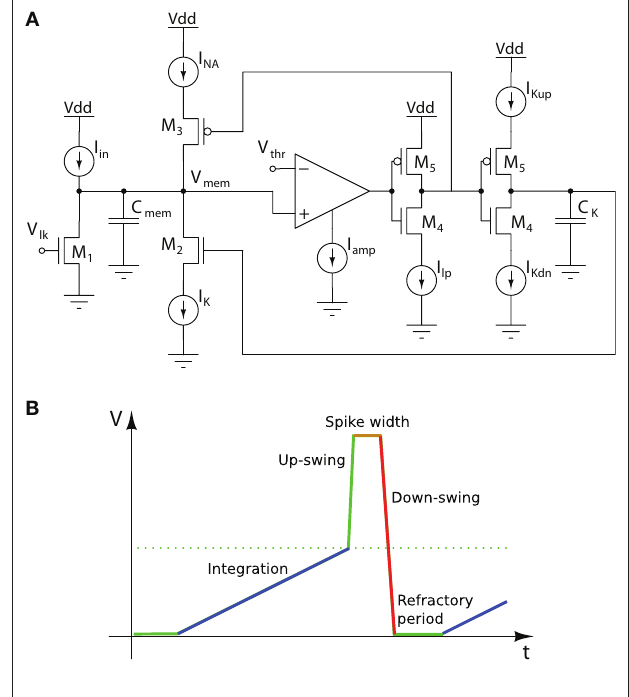
FIgure 4 | Voltage-amplifier I&F neuron. ( A) Schematic diagram; (b) Membrane voltage trace over